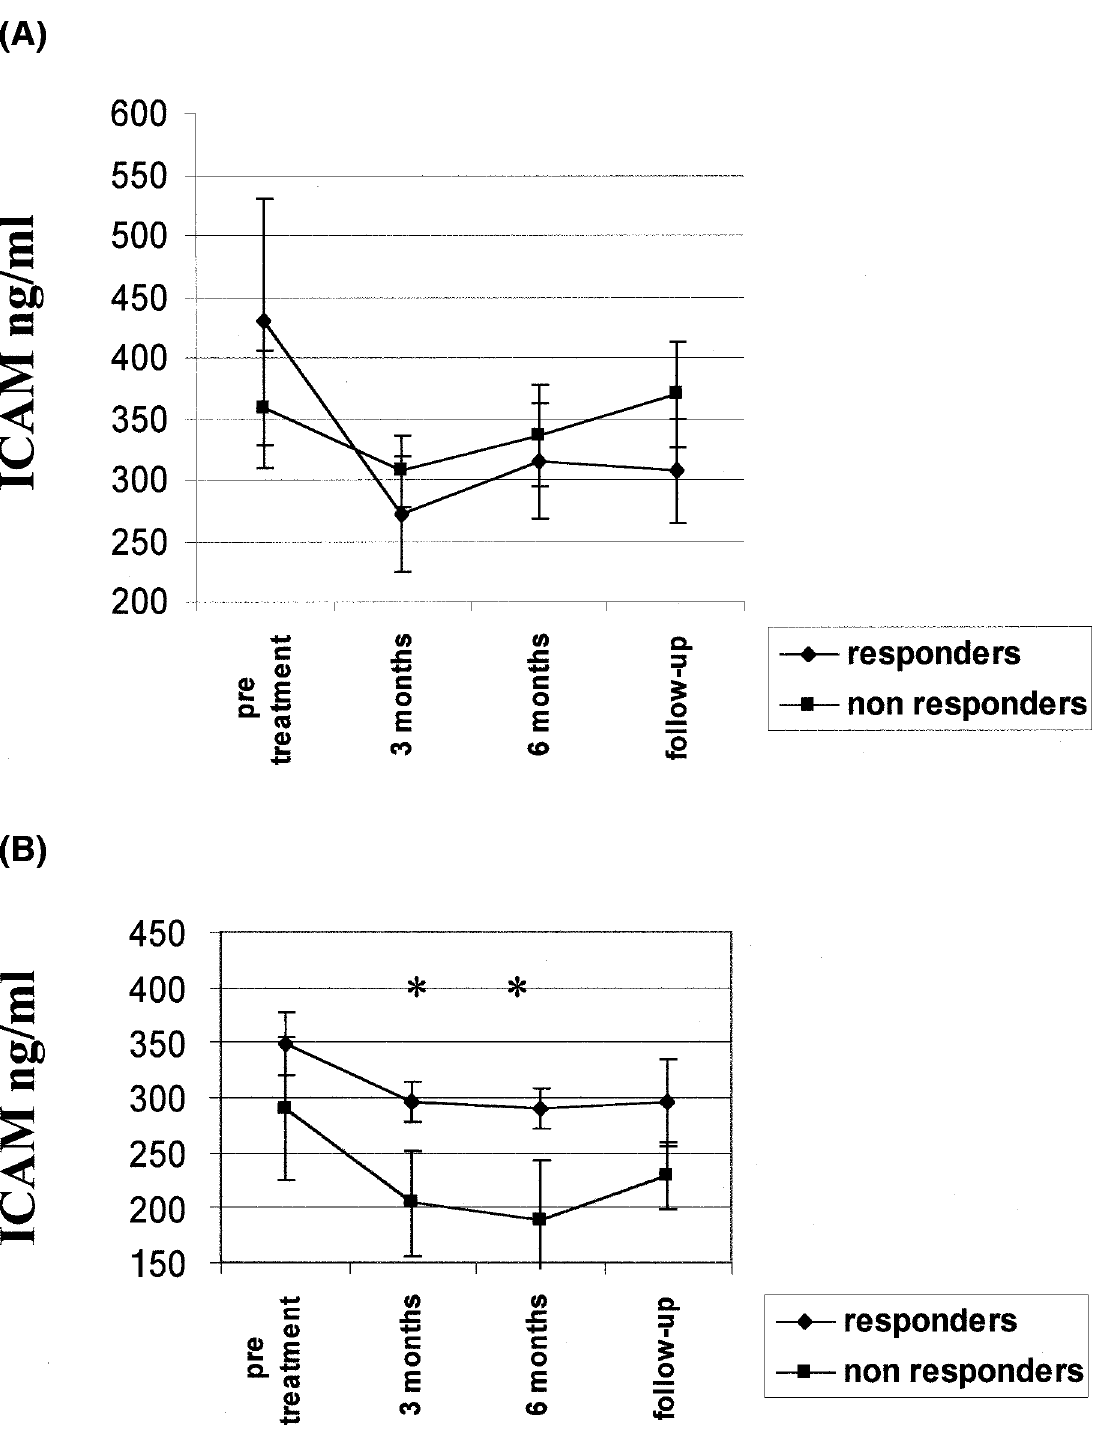
FIG. 1. (A) ICAM-1 levels (ng/ml) in responders ( n = 10) versus non-responders ( n = 23) to IFN-alpha monotherapy. (B) ICAM-1 levels (ng/ml) in responders ( n = 9) versus non-responders ( n = 13) to IFN-alpha + ribavirin combination therapy. (Results expressed as mean ±